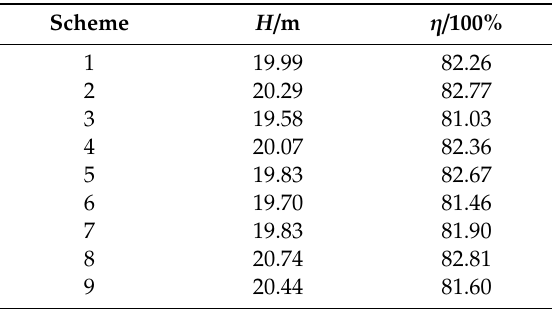
Table 9. Simulation results in orthogonal design.